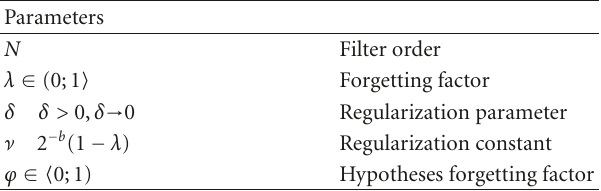
Figure 2: RLS lattice algorithm for identification of one- dimensional autoregression model. Table 1: The parameters of the RLS lattice algorithm with exponential forgetting and probability update